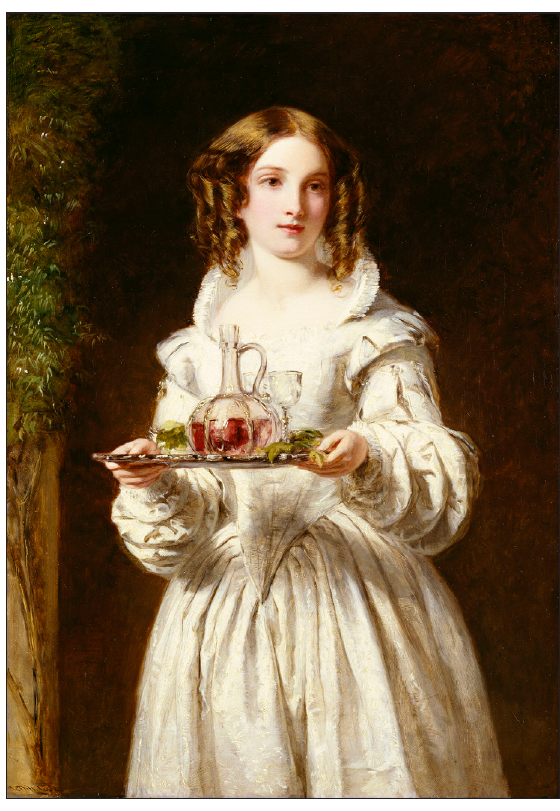
Fig. 9 : William Powell Frith, Anne Page , 1852, oil on canvas, 45.9 × 32.9 cm <www.rct.uk/collection/404603>. Royal Collection Trust/© Her